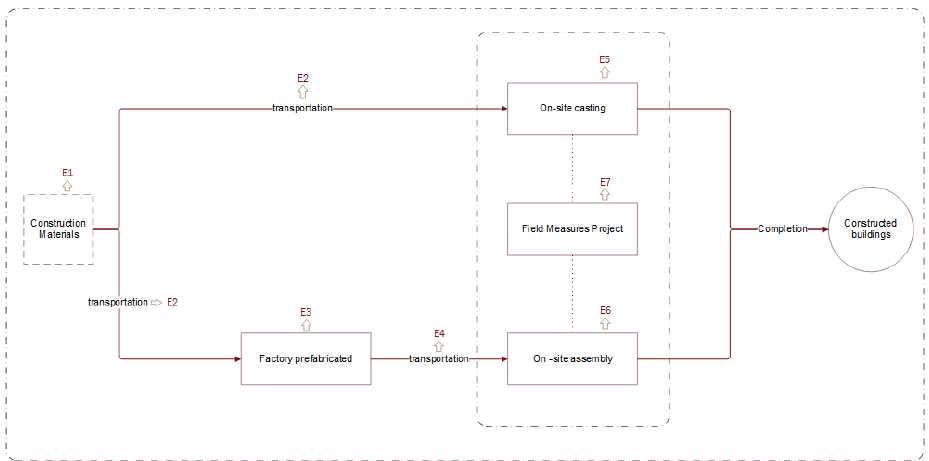
Figure 2. Carbon emission sources for assembled